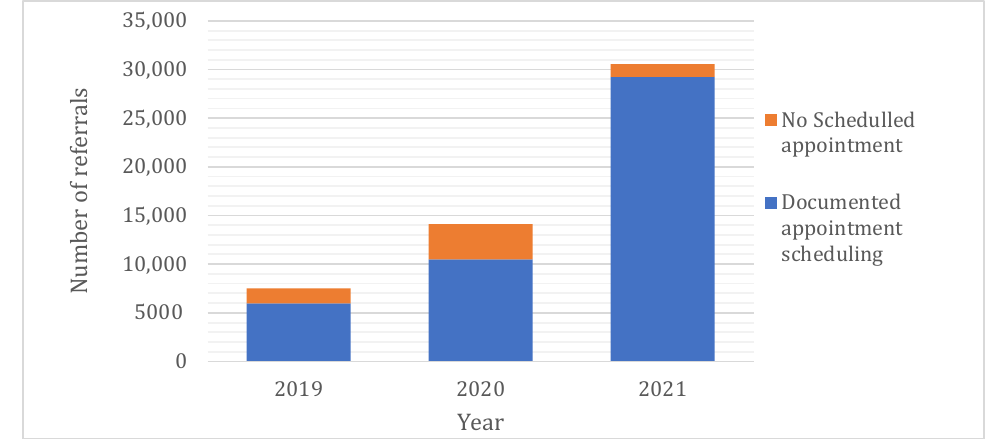
Figure 3. Distribution of referrals outcomes overtime ( n = 52,143, 2019 – 2021).